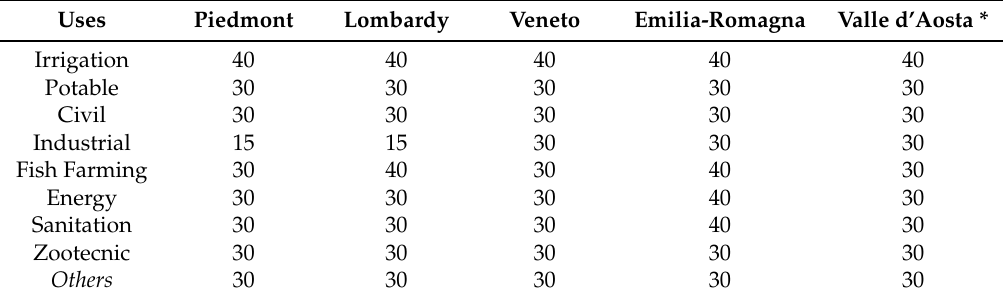
Table 3. Terms of water uses for regions comprised regions included in the PRBD (source: own elaboration from [51–55]). Legend: * In the case of water rights allotted prior to 1956, Valle d’Aosta